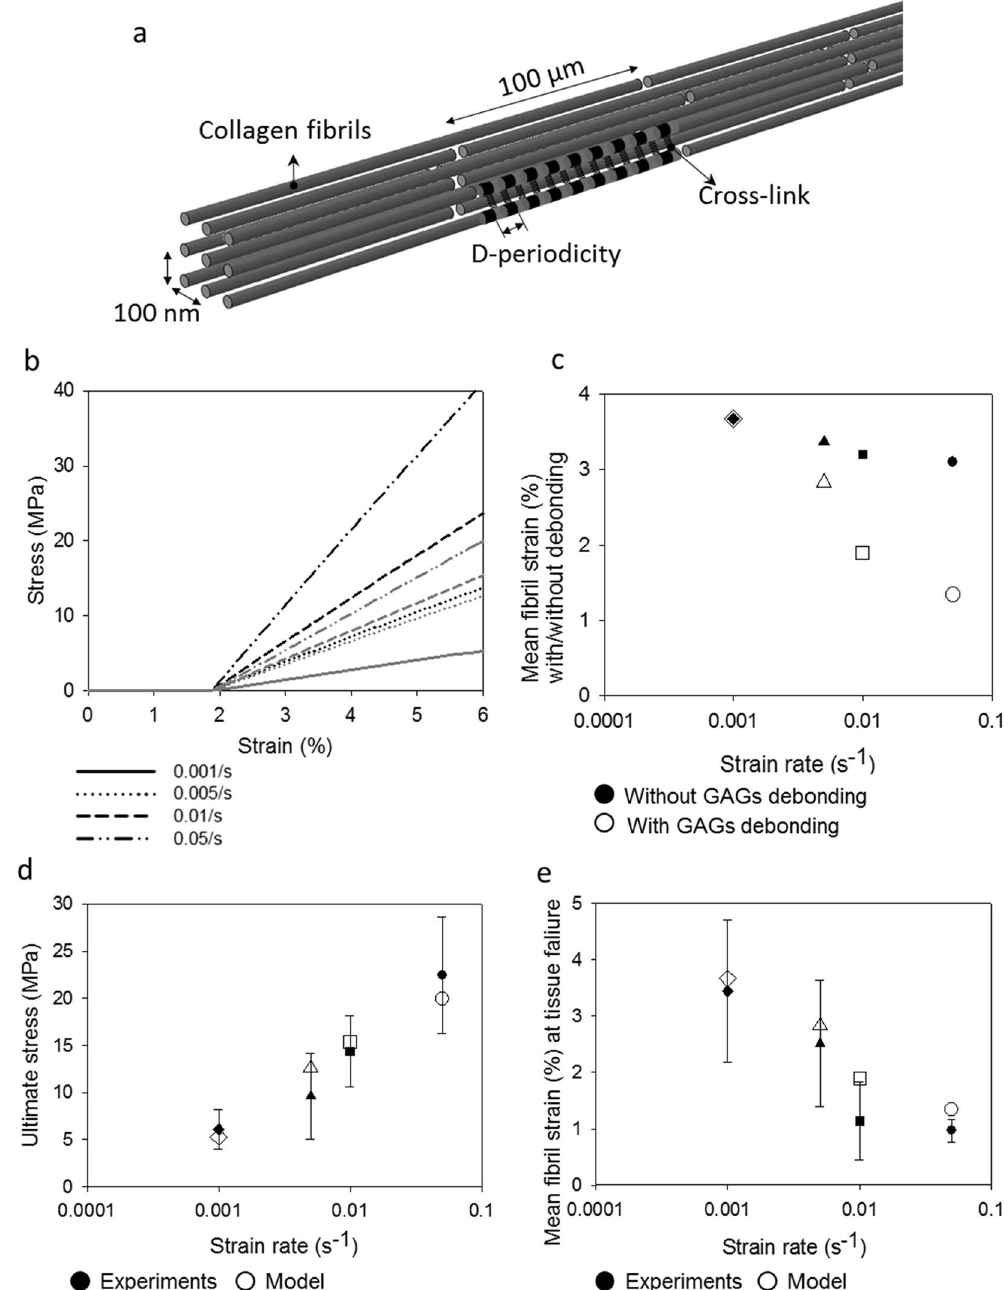
Figure 4. Computational model verification. ( a ) Finite Element model of fibril networks: individual fibrils consist of overlap (black) and Gap (grey) regions of tropocollagen fibrils, interconnected with neighbouring collagen fibrils through cross-links (black springs). Due to periodicity, a unit cell of two individual fibrils were modelled. ( b – e ) Finite element modelling results of the strain rate dependent mechanical behaviour of ligament tissue: ( b ) stress-strain curves of ligament tissue with (grey dash lines) and without (black dash lines) cross-links debonding; ( c ) mean fibril strain with (hollowed) and without (filled) cross-links debonding for both overlaps and gap regions of collagen fibrils at different strain rates; comparing ( d ) ultimate stress and ( e ) mean fibril strain at different strain rates. Error bars are standard deviations for the experimental data only (n = 5 for each